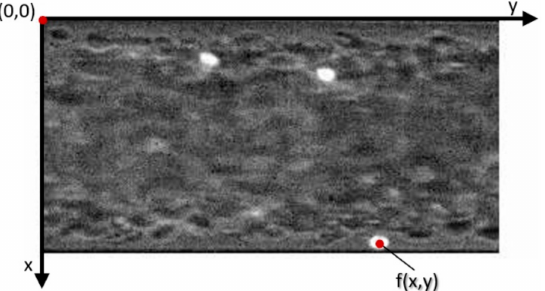
Figure 2. Image of blood flow in the microchannel with labeled bright RBCs, f(x,y) and the centroid of the tracking